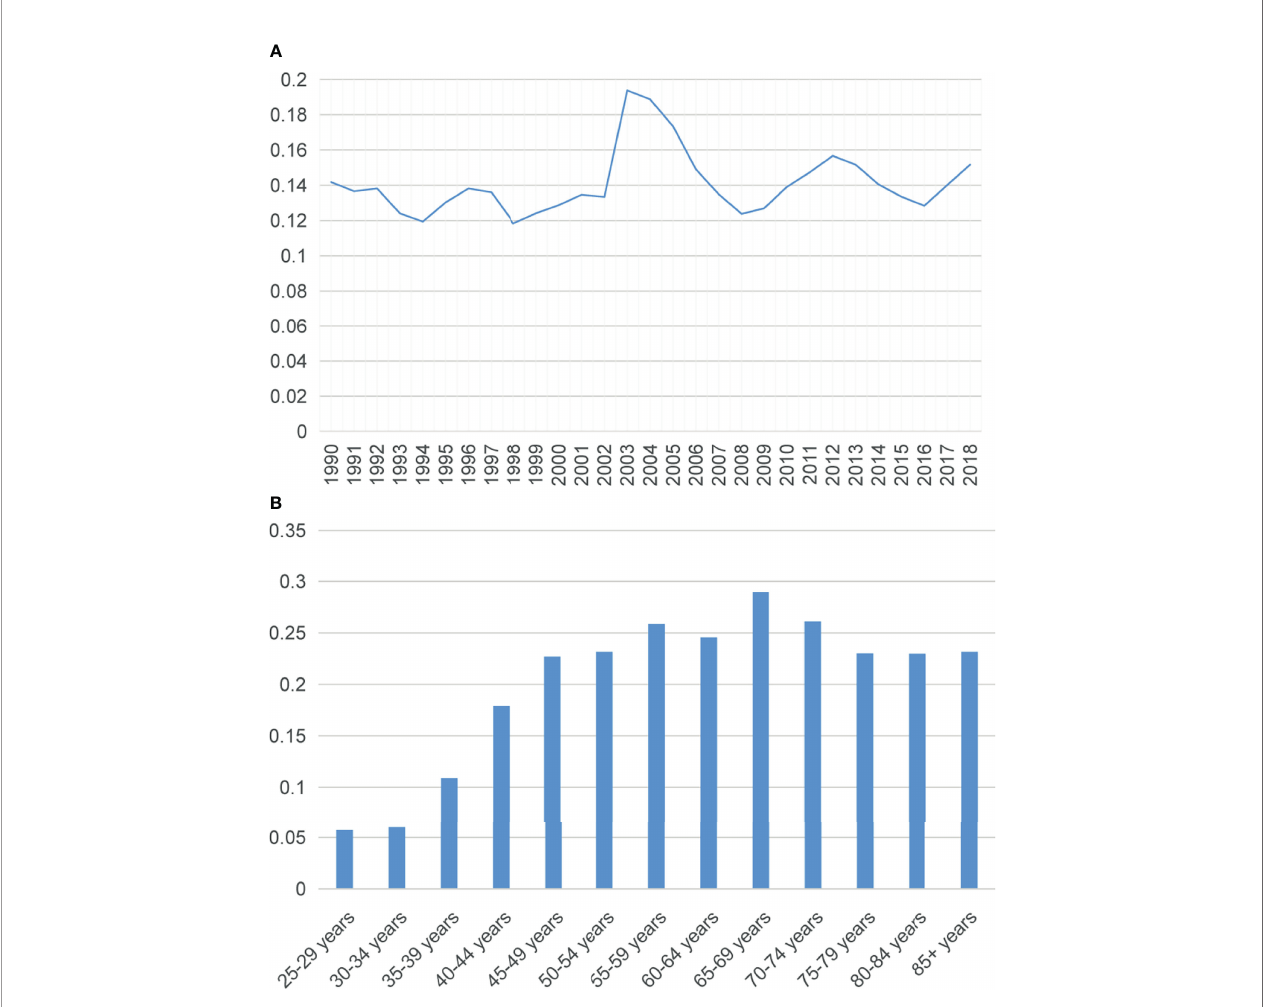
FIGURE 2 | (A) Trend in the incidence of small cell carcinoma of the breast from 1990 to 2018. (B) Age-wise incidence. All rates were per 1,000,000, and age was adjusted to the 2000 US standard